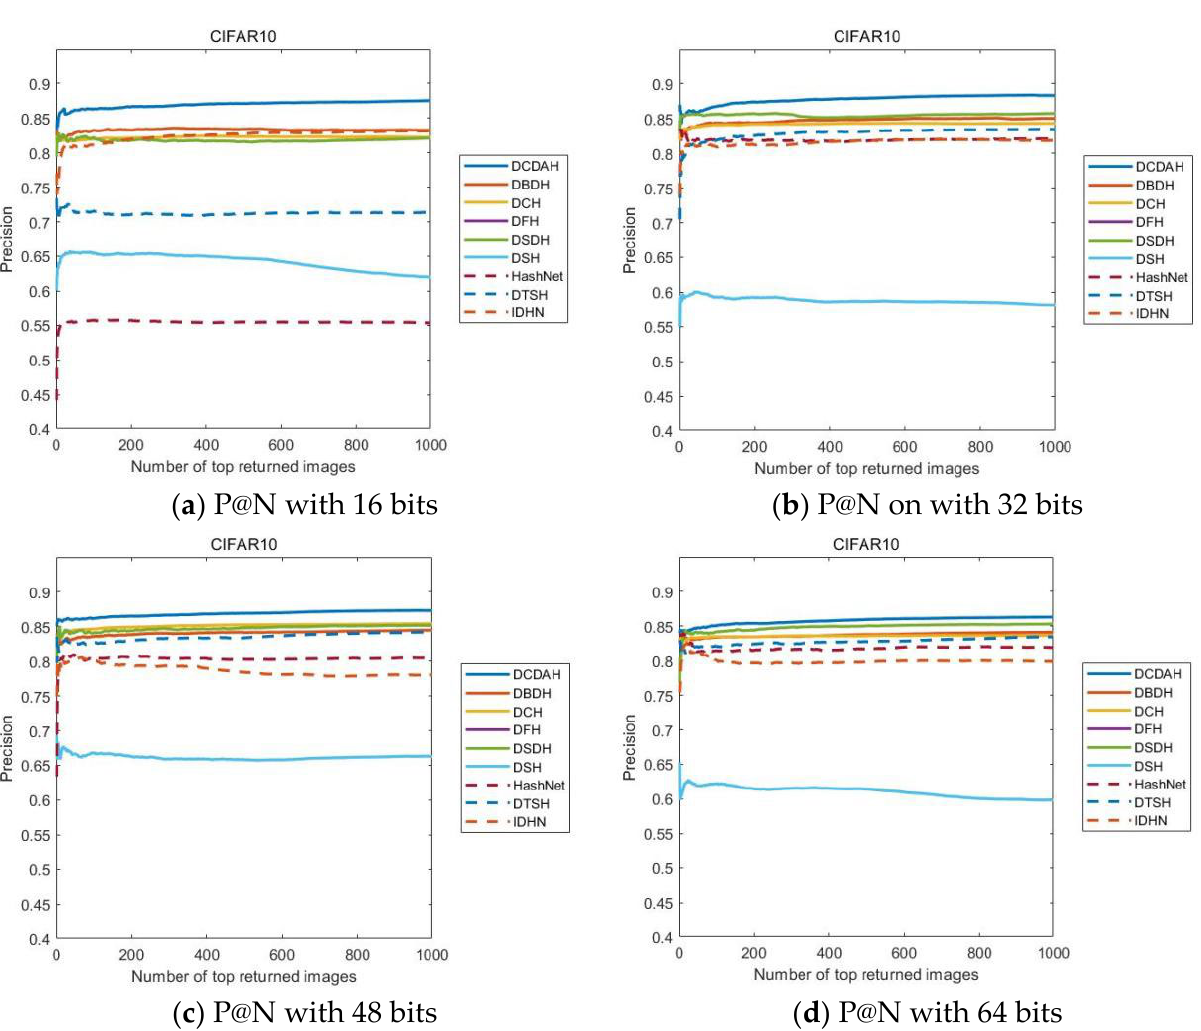
Figure 8. The P@N curves of all algorithms on CIFAR10 when the hash code takes 4 different lengths.